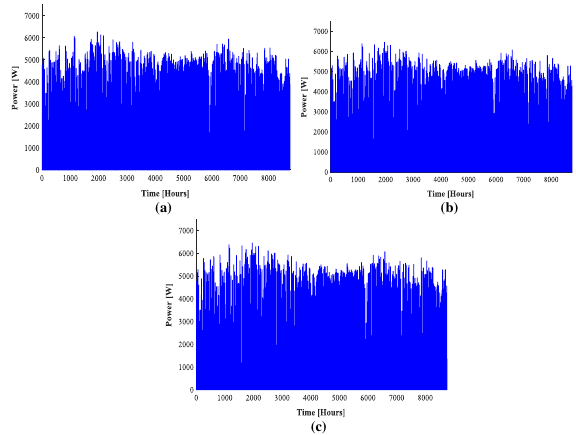
Fig. 16 Annual generated power using different MPPT techniques on the Poly-Si MSX60 PV array a P&O MPPT, b IC MPPT, c SM-MPPT